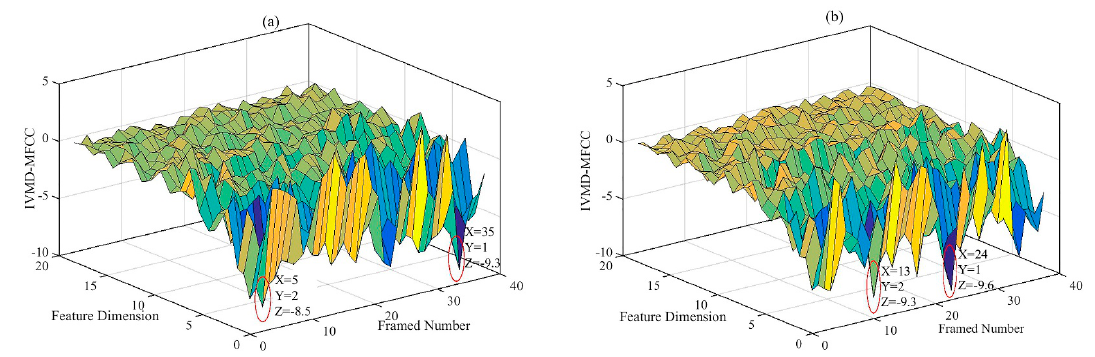
Figure 10. Results for a new feature IVMD-MFCC: ( a ) NVC; ( b ) SFI.